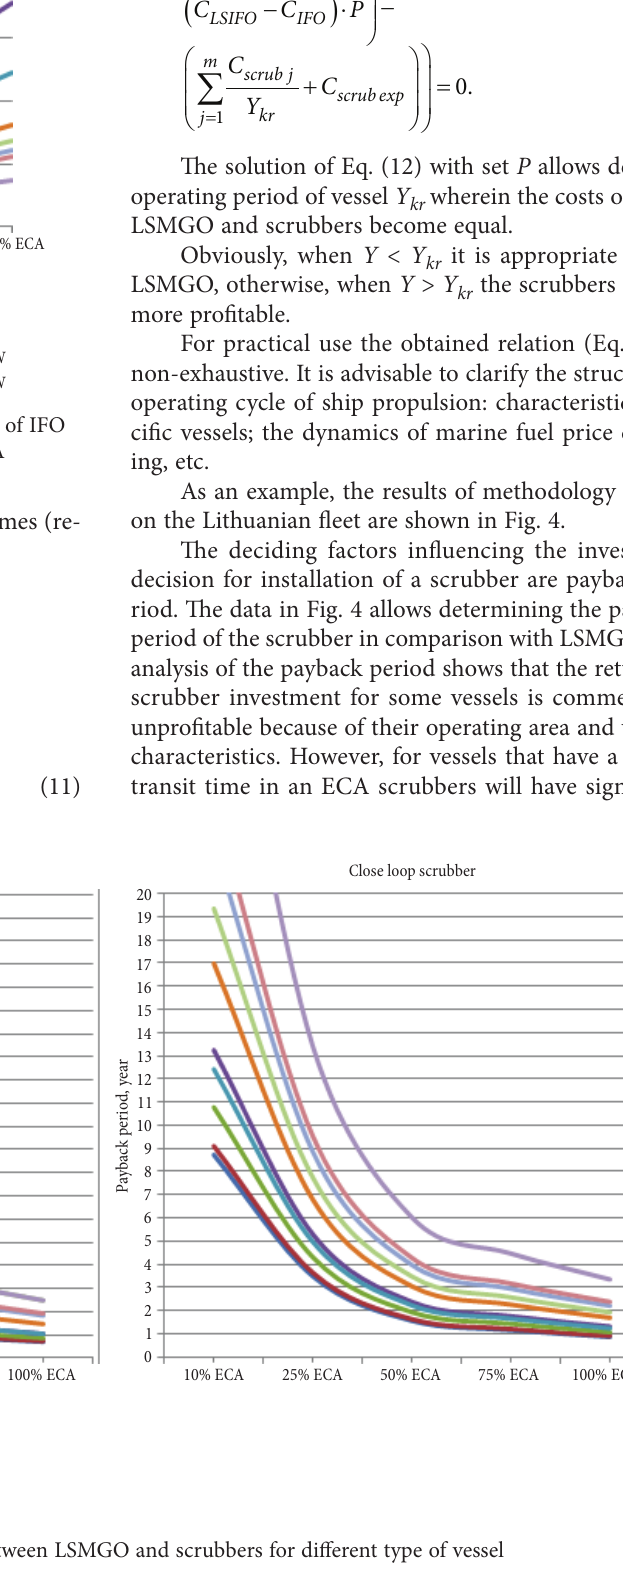
Fig. 4. Advisability of choice between LSMGO and scrubbers for different type of